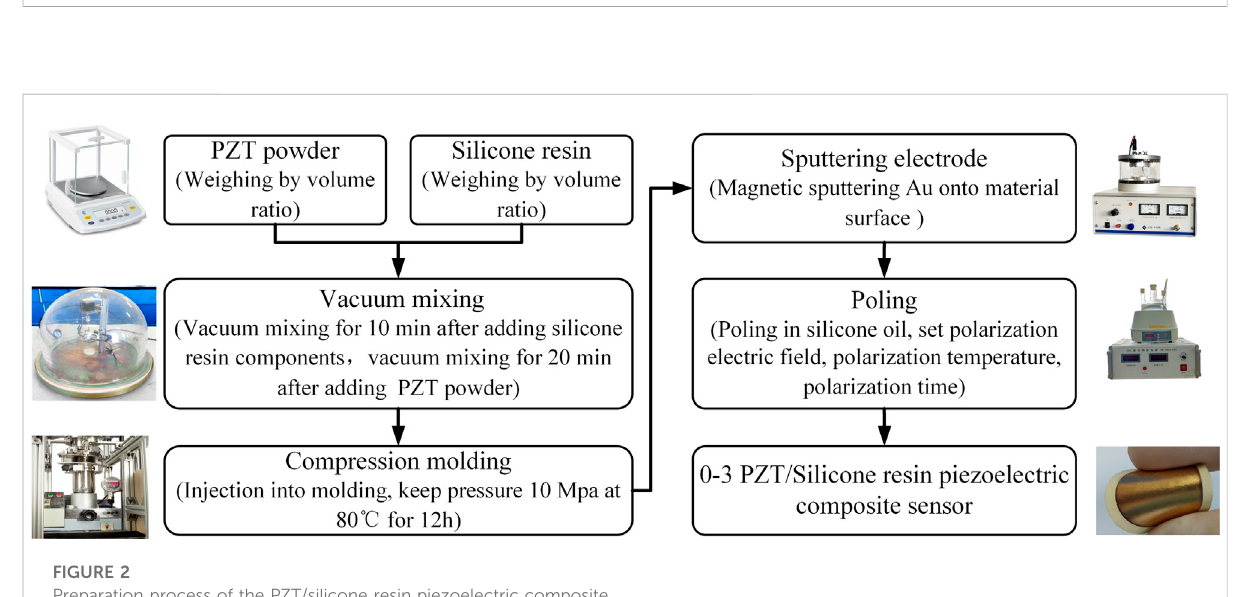
FIGURE 2 Preparation process of the PZT/silicone resin piezoelectric